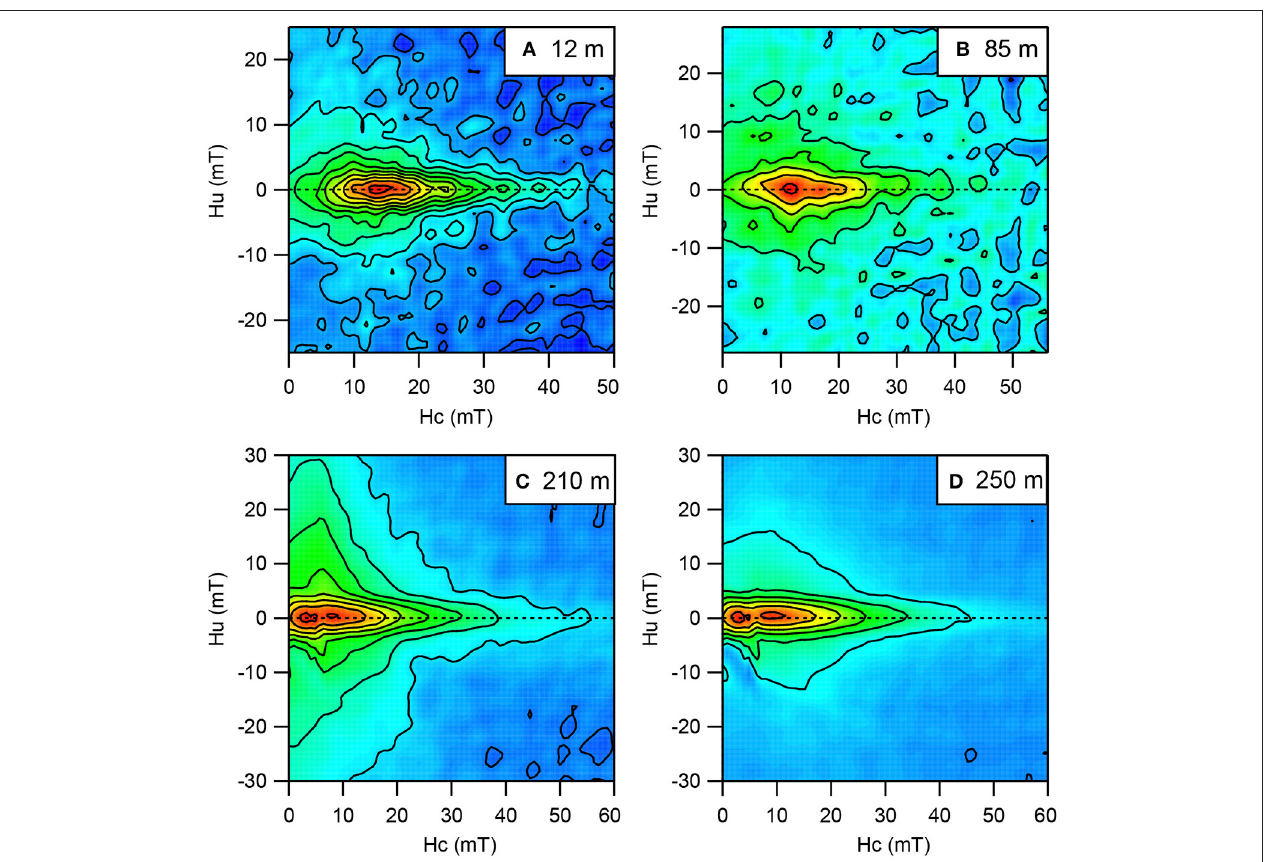
FIGURE 4 | FORC diagrams of typical samples. (A) 12m, (B) 85m, (C) 210m, and (D) 250m.